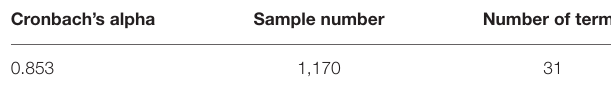
TABLE 6 | Reliability test results of the whole scale.